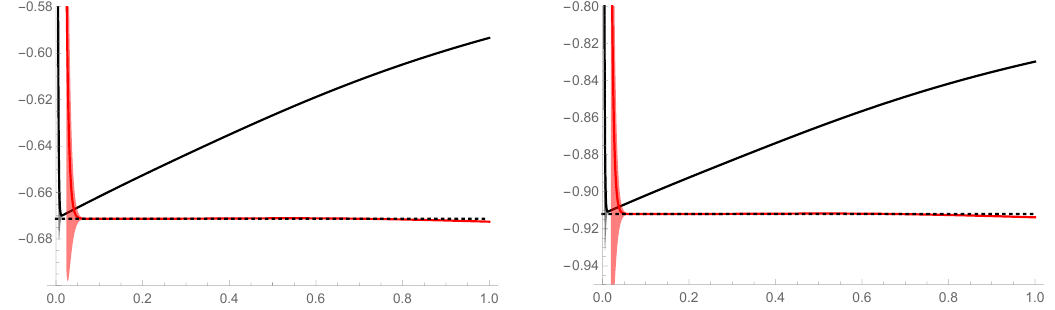
Figure 14 . The poles of the Borel-Padé approximant of the series ¯ e m (4.53) for the PCF, truncated at 120 terms. The plot on the left corresponds to N = 4 (left) while the one in the right corresponds to N = 5 . The dashed line indicates the predicted position of first unconventional renormalon singularity ζ = 2 / (1 − ∆) , and the black circle indicates the position of the removed IR singularity at ζ = 2 .